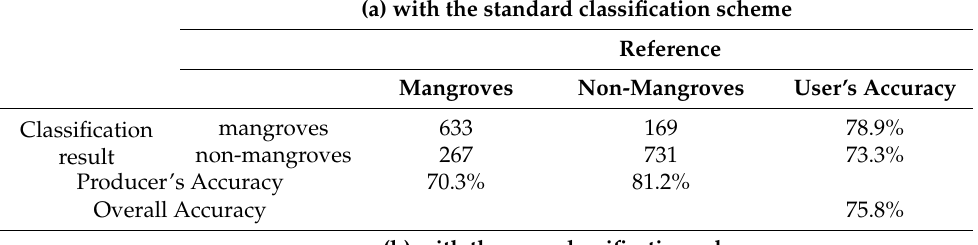
Table 4. Confusion matrices of the classifications without correction with a standard classification scheme and a new classification scheme in the first experiment. The performance of classification with the standard scheme is shown in ( a ), and that with the new scheme is shown in ( b ). (a) with the standard classification scheme